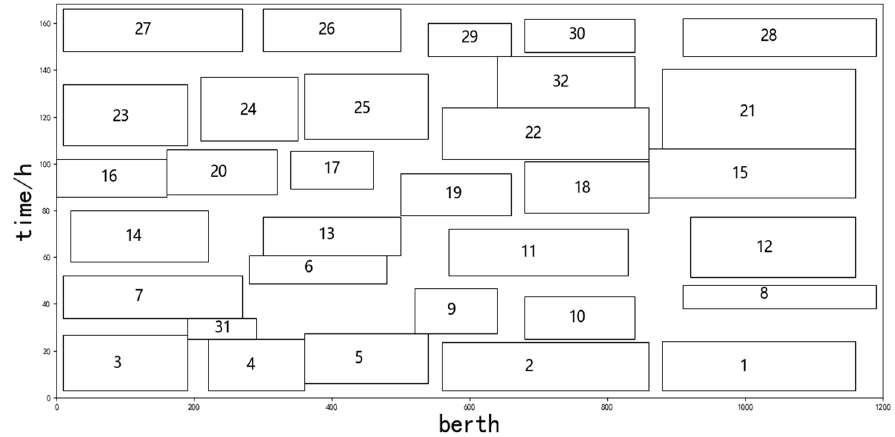
Figure 6. Rescheduling scheme diagram.